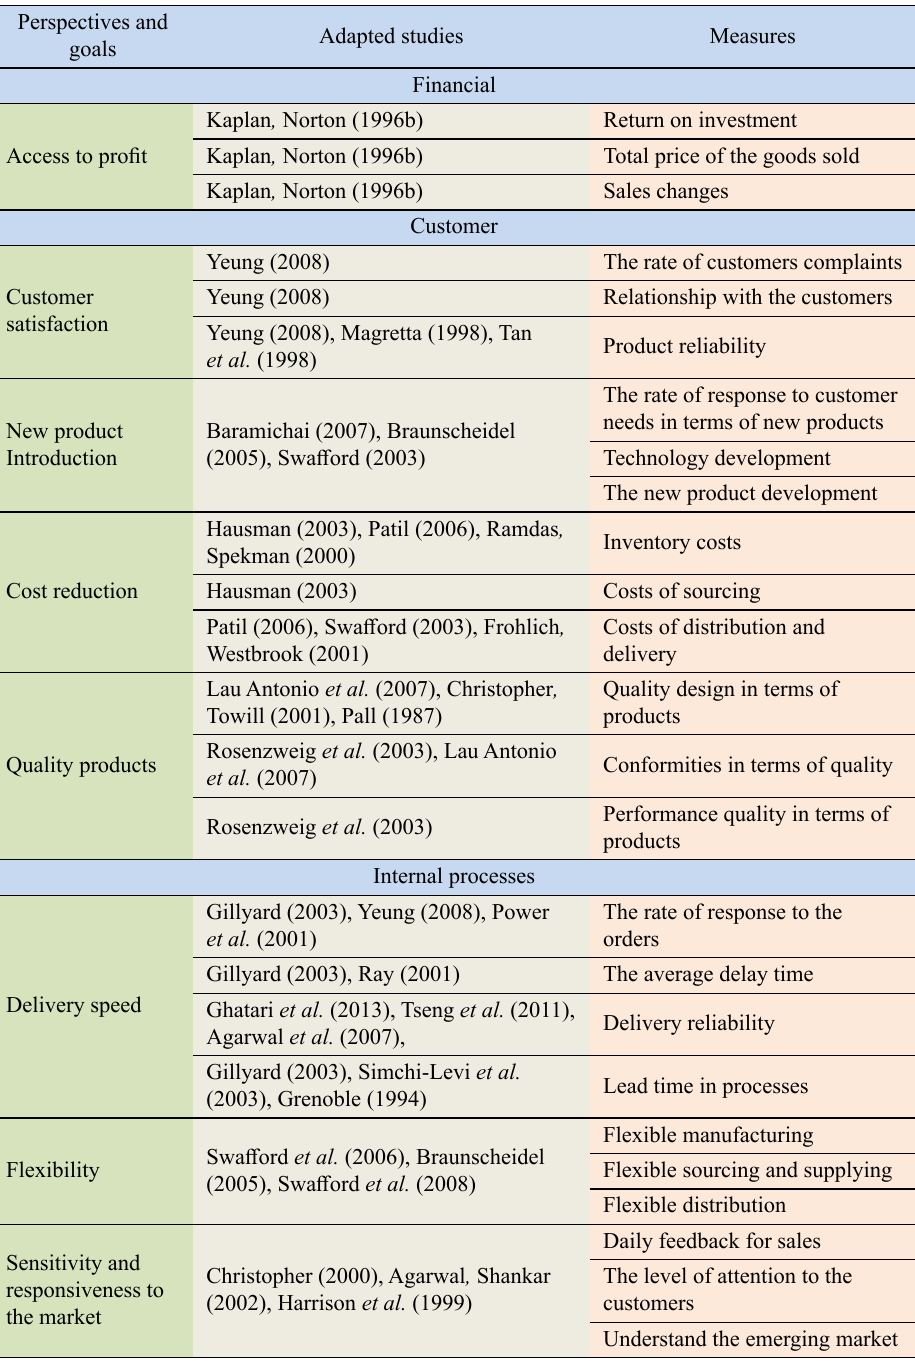
Table 2. Adapted objectives and measures through literature